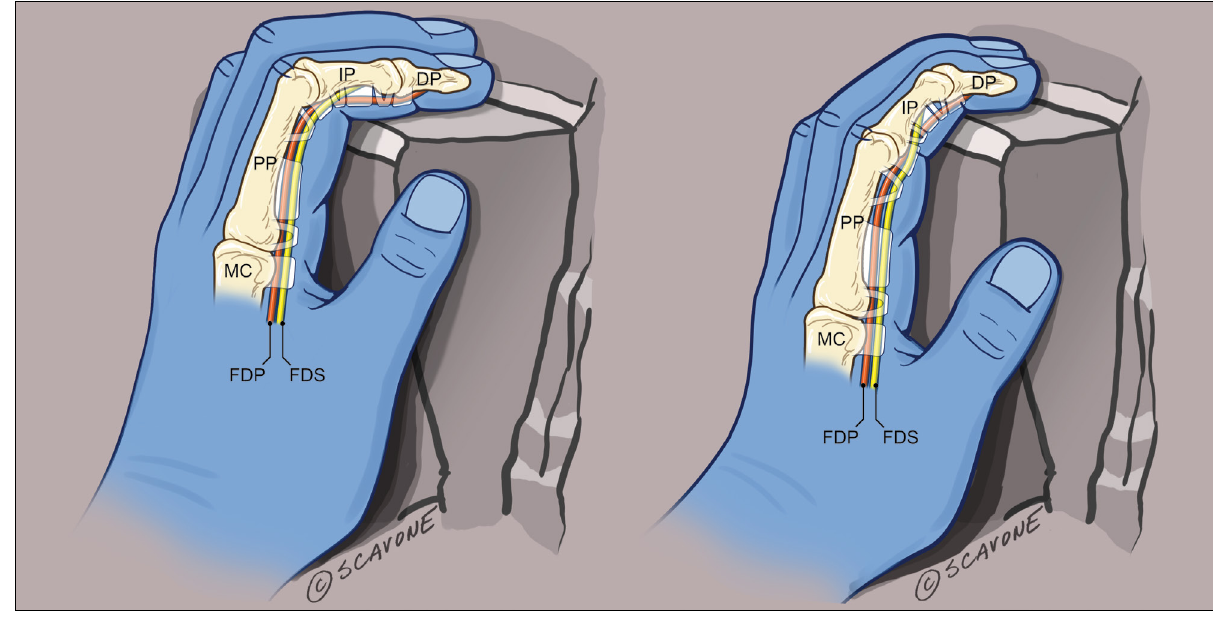
Figure 2: Common handholds on rock surfaces and the underlying flexor tendon pulley system. Up to 90% of climbers use the crimp grip ( left ), where the proximal interphalangeal (PIP) joints are flexed from 90° to 100° and the distal interphalangeal (DIP) joints are either fully extended or hyperextended. 17 The second most common grip is the slope grip or open hand grip ( right ), which is distinguished by extended or slightly flexed PIP joints and flexion (50° to 70°) of the DIP joints.